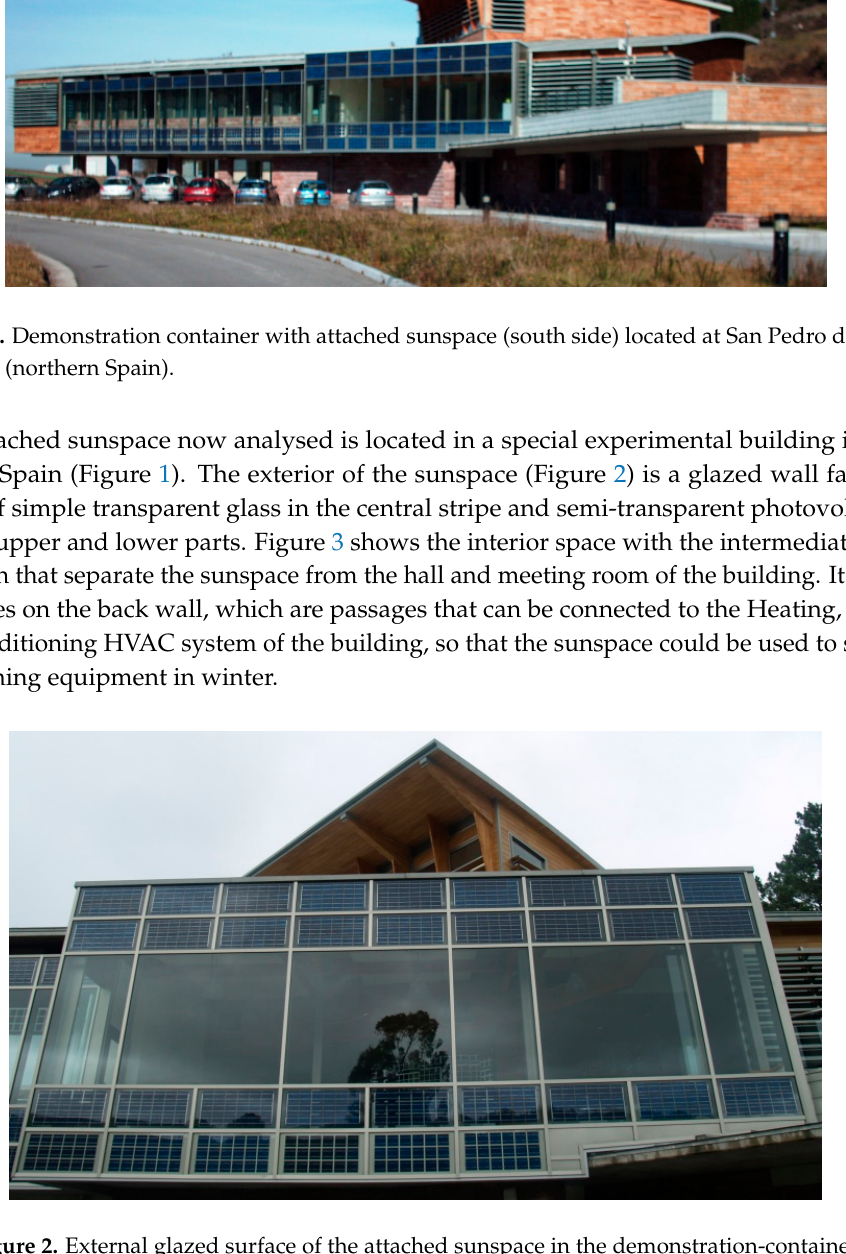
Figure 2. External glazed surface of the attached sunspace in the demonstration-container.